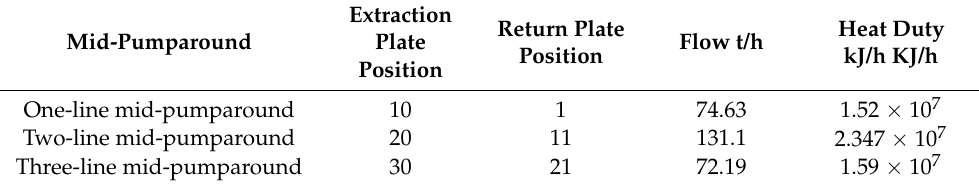
Table 5. Circulating parameters of vacuum column in the middle section.